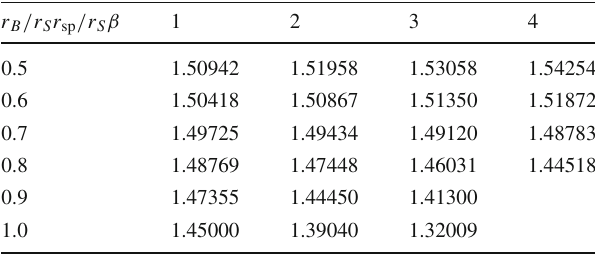
Table 1 The radii of the photon sphere with plasma for different values of r B and